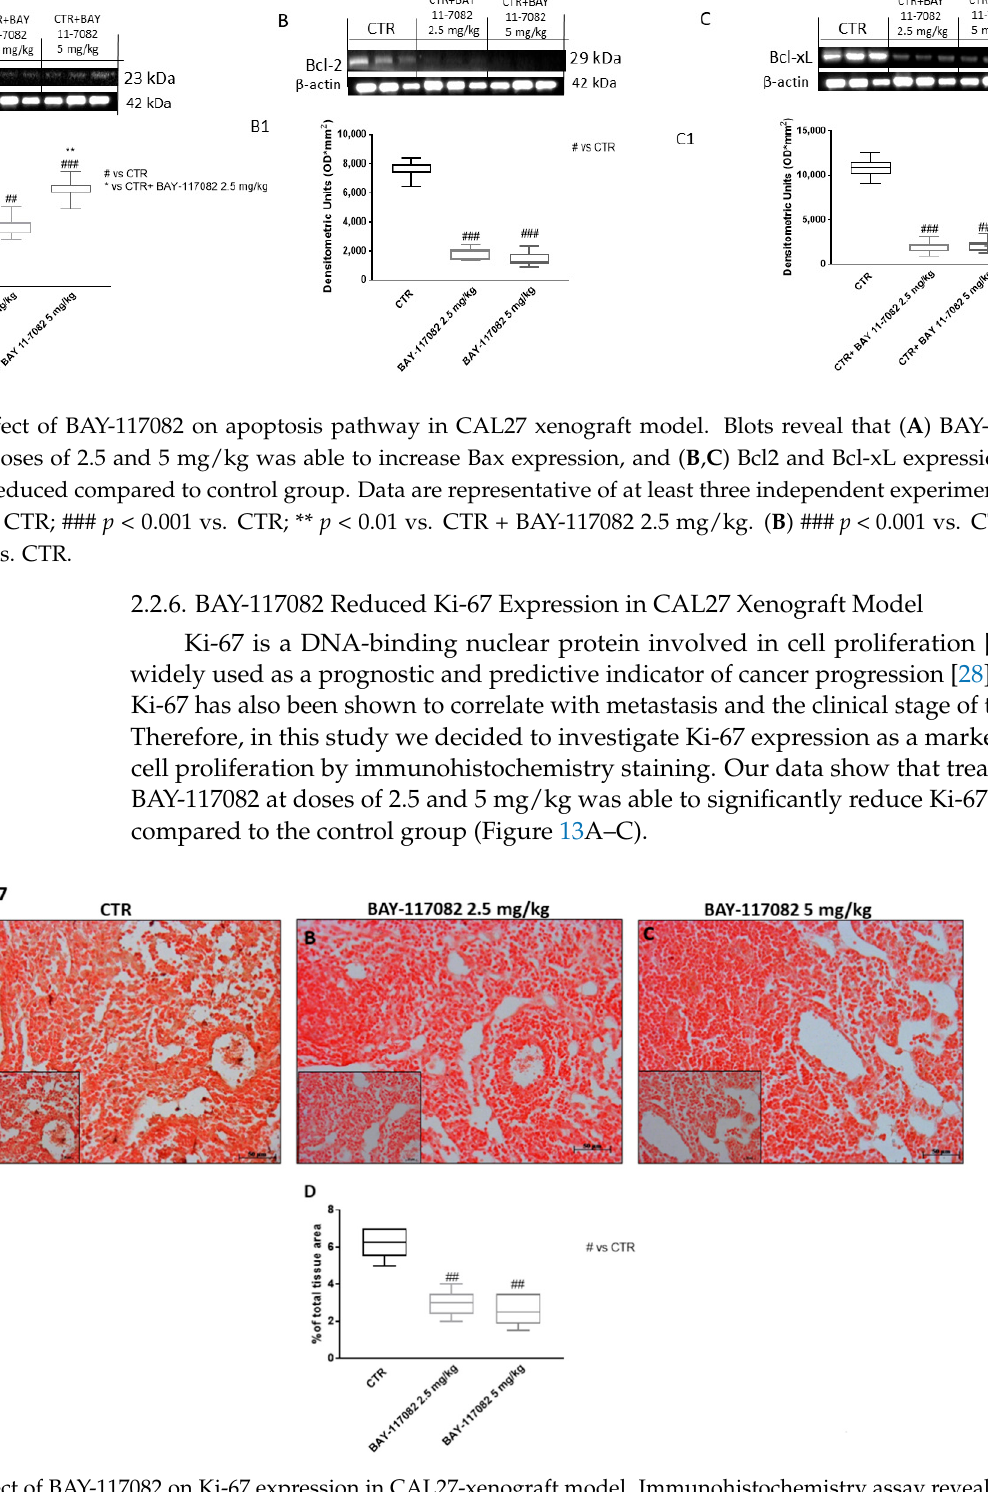
Figure 13. Effect of BAY-117082 on Ki-67 expression in CAL27-xenograft model. Immunohistochemistry assay revealed that ( A ) control group was characterized by marked Ki-67 expression, and ( B , C ) treatment with BAY-117082 at doses of 2.5 and 5 mg/kg significantly reduced its expression. Data are representative of at least three independent experiments. Sections were observed and photographed at 20× and 40× magnification. ( D ) ## p < 0.01 vs. CTR.